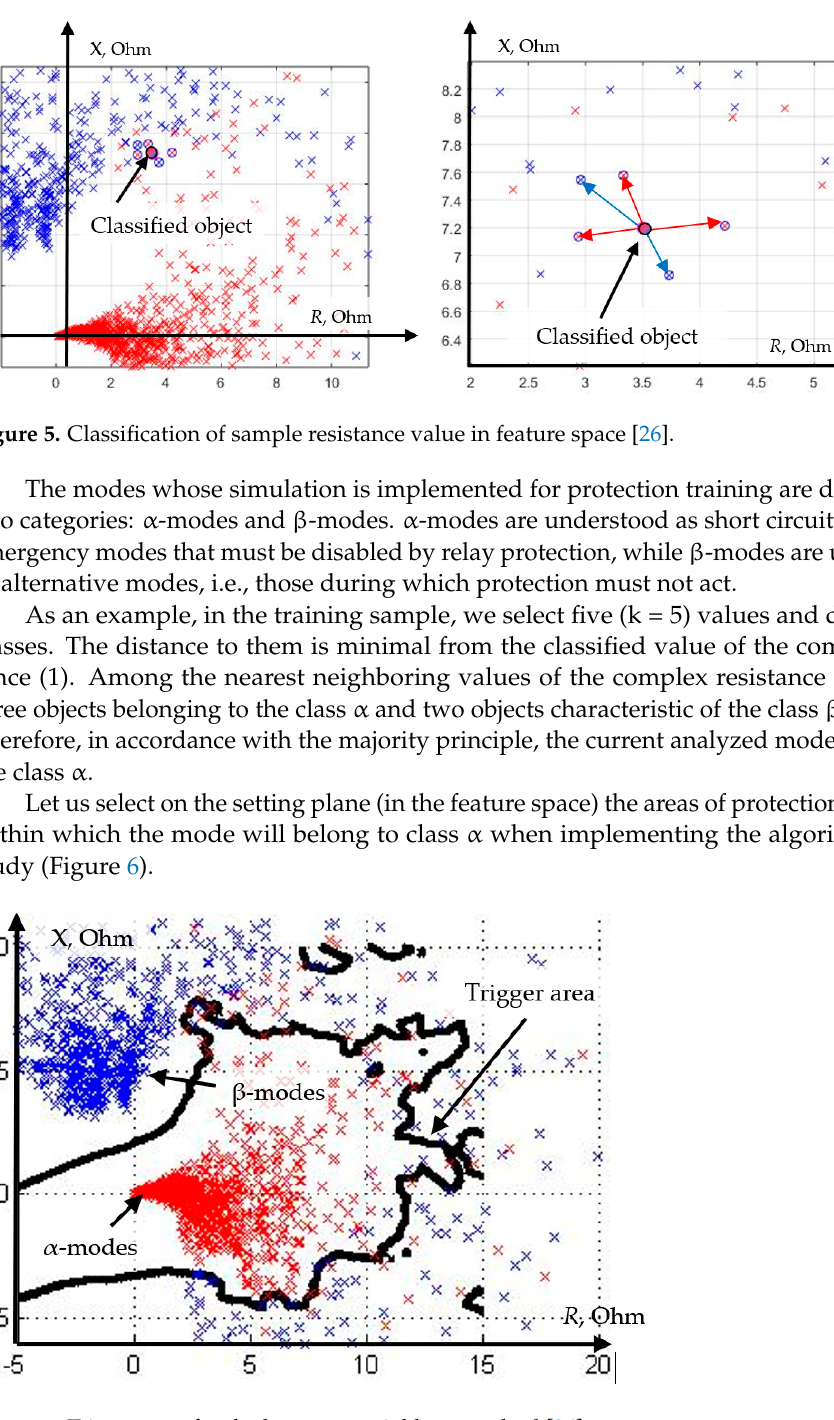
Figure 6. Trigger area for the k-nearest neighbors method [26]. Table 1. Error matrix corresponding to the k-nearest neighbors method [26].